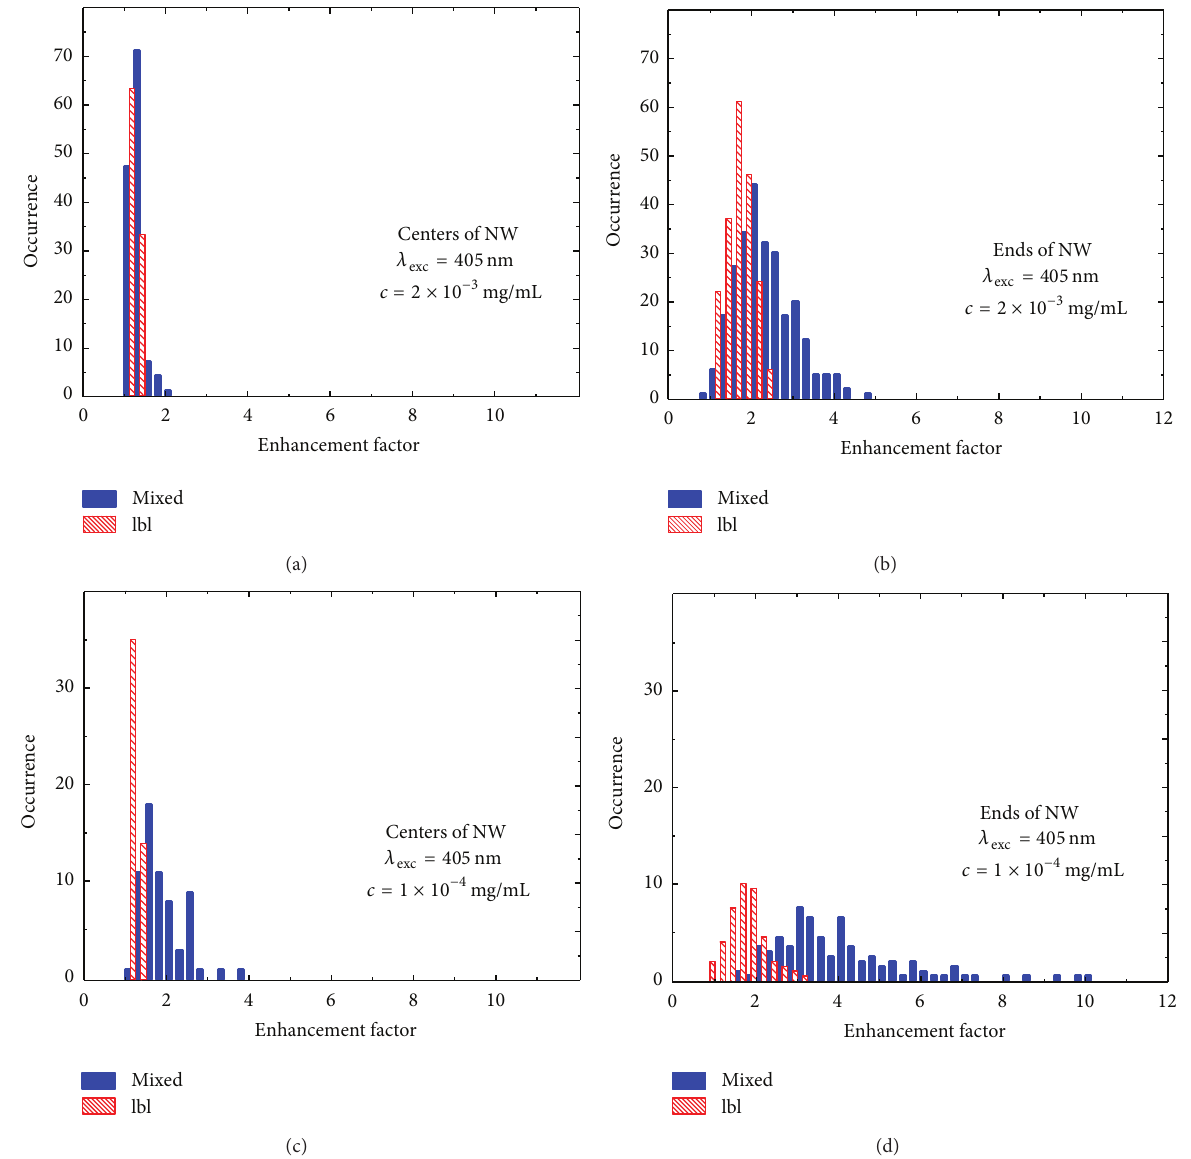
Figure 5: Histograms of the enhancement factors determined for the mixed (solid bars) and layer-by-layer (dashed bars) samples with the PCP complexes excited at 405nm. Data shown in (a) and (b) correspond to the PCP concentration of 2 × 10 −3 mg/mL and for the central parts of NW and for the ends of NW, respectively. Data shown in (c) and (d) correspond to the PCP concentration of 1×10 −4 mg/mL and for the central parts of NW and for the ends of NW,